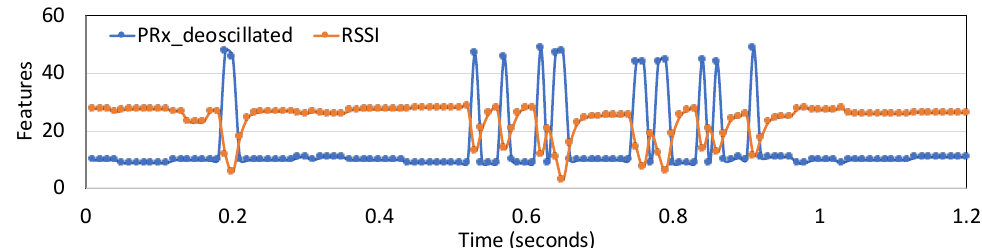
Figure 3. Variation of the two features PRx_deoscillated and RSSI_from_min for 1.2 s.